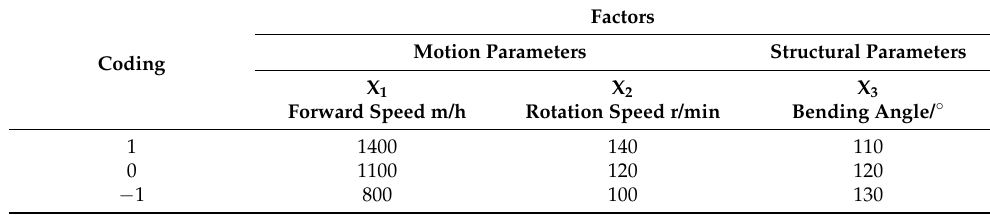
Table 3. Simulation test factor